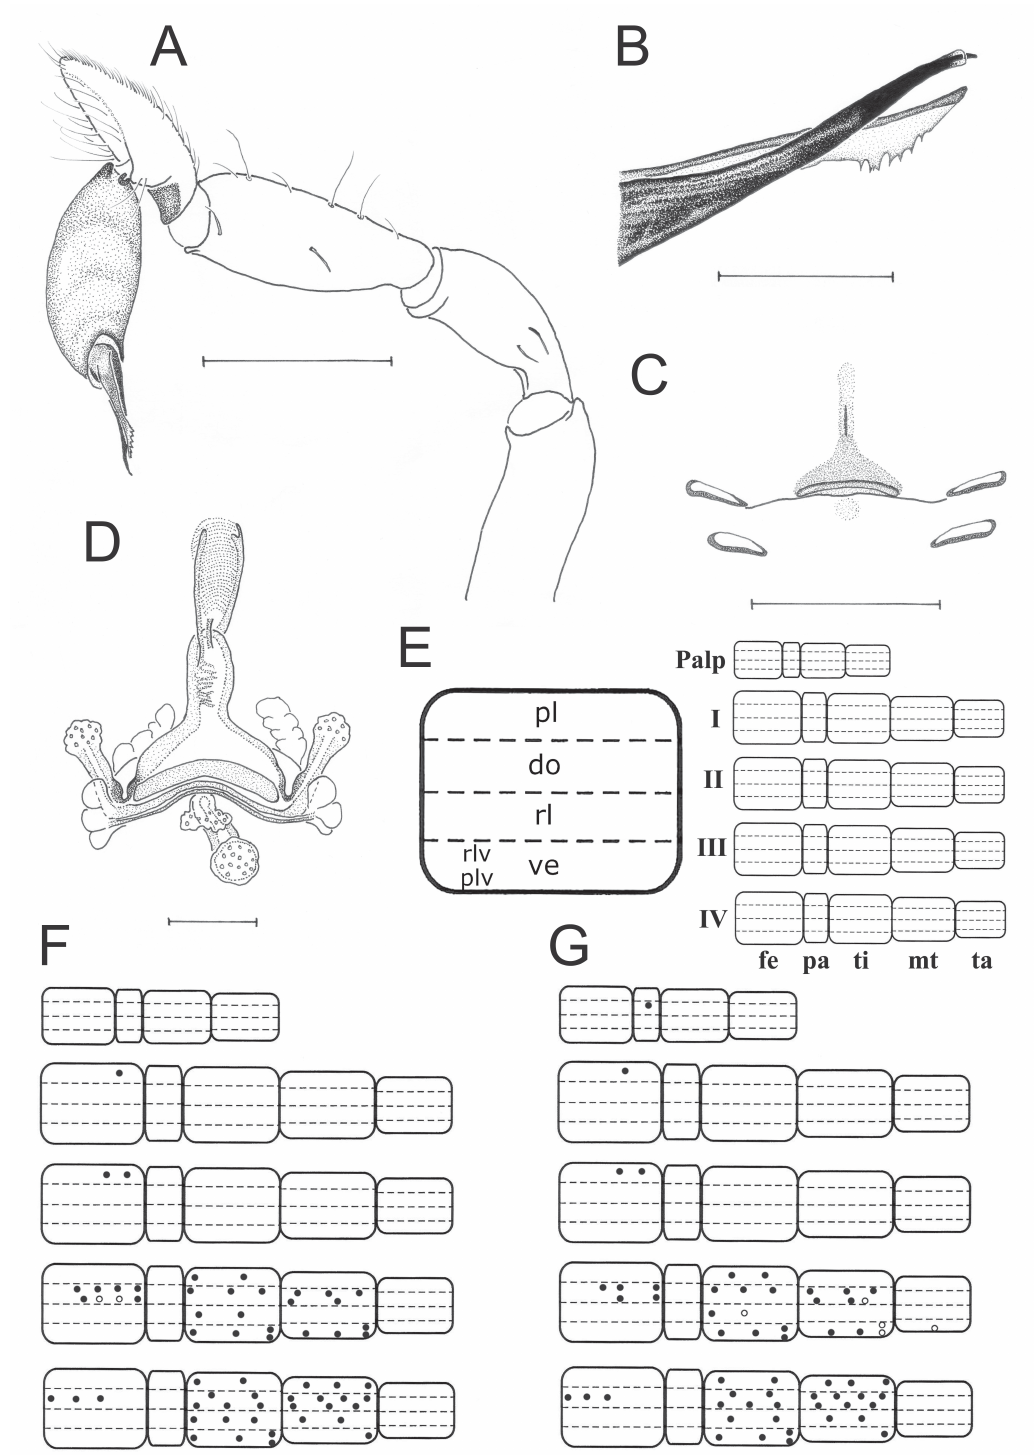
Fig. 1. Harpactea dufouri (Thorell, 1873), Mont Ras specimens . A . Male palp, prolateral view. B . Tip of male embolus and conductor, retrolateral view. C . Endogyne, external ventral view, uncleared. D . Cleared vulva, ventral view. E . leg spination scheme, legend. F . Leg spination scheme of male. White dots are spines present on one leg and absent on the other. G . Leg spination scheme of female. White dots are spines present on one leg and absent on the other. Scale bars: A, C = 0.5 mm; B, D = 100